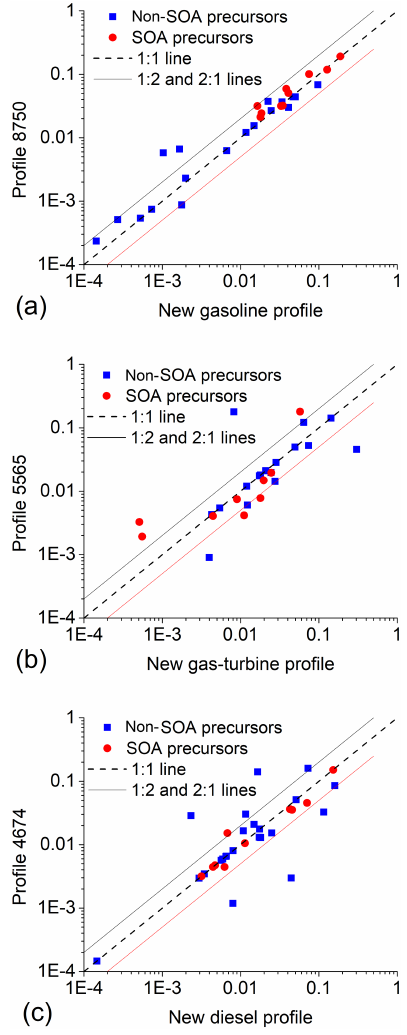
Figure 5. Scatter plot of VOC groups in the SAPRC mechanism in the new profiles and in the SPECIATE database for (a) on- road gasoline, and cold-start (b) gas-turbine and (c) non-DPF diesel sources, demonstrating consistency between traditional and new profiles in VOC